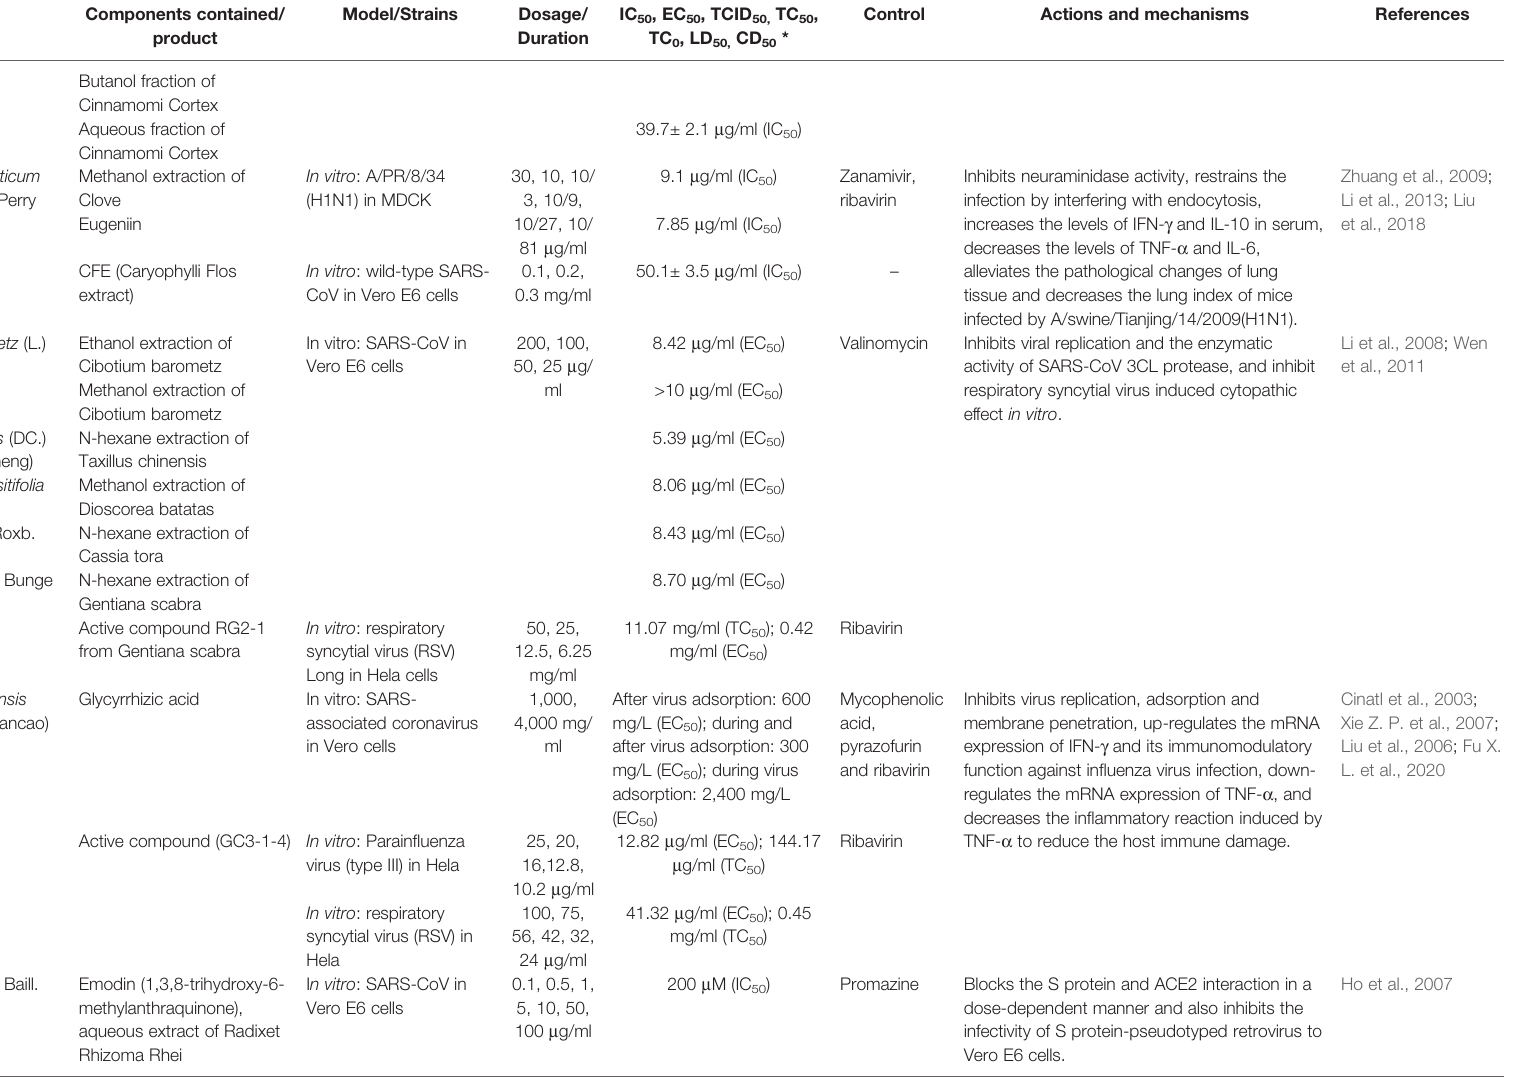
Blocks the S protein and ACE2 interaction in a dose-dependent manner and also inhibits the infectivity of S protein-pseudotyped retrovirus to Vero E6 cells.